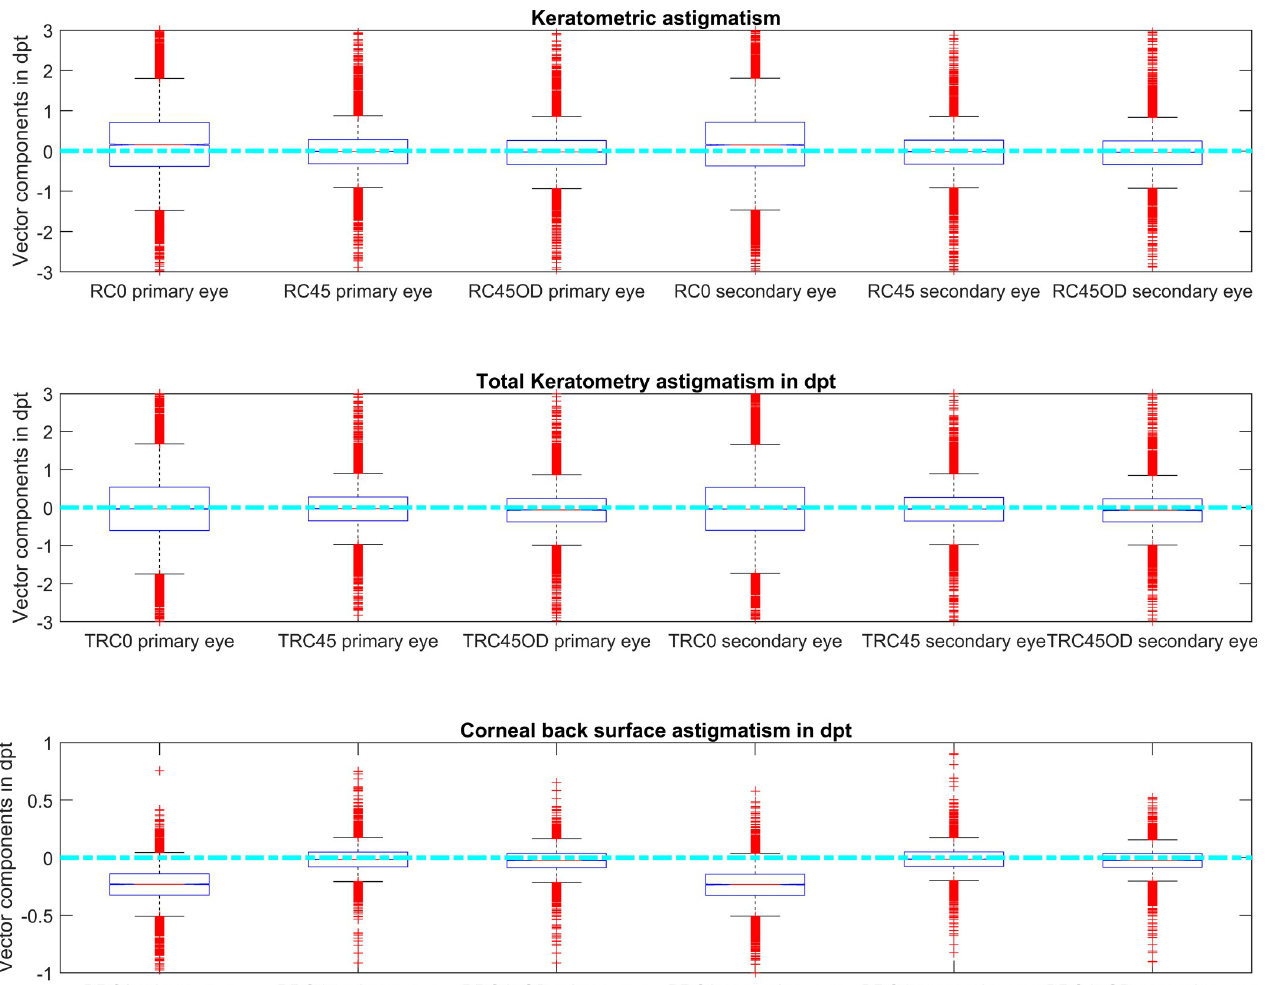
Fig 1. Boxplot of the power vector components for keratometry (upper graph), total keratometry (middle graph) and corneal posterior surface (lower graph). RSEQ, TRSEQ and BRSEQ refer to the equivalent power of keratometry, total keratometry and corneal back surface power, and RC0 / TRC0 / BRC0 and RC45 / TRC45 / BRC45 to the projection of the astigmatism to the 0˚ / 90˚ and the 45˚ / 135˚ meridians for keratometry / total keratometry / corneal back surface, respectively. RC45OD / TRC45OD / BRC45OD show the astigmatic vector components with RC45 / TRC45 / BRC45 for left eyes flipped in sign. The entire dataset is split randomly into primary eyes (to be treated with cataract surgery) and secondary eyes (whose biometry is used). The cyan line indicates stigmatic cases.